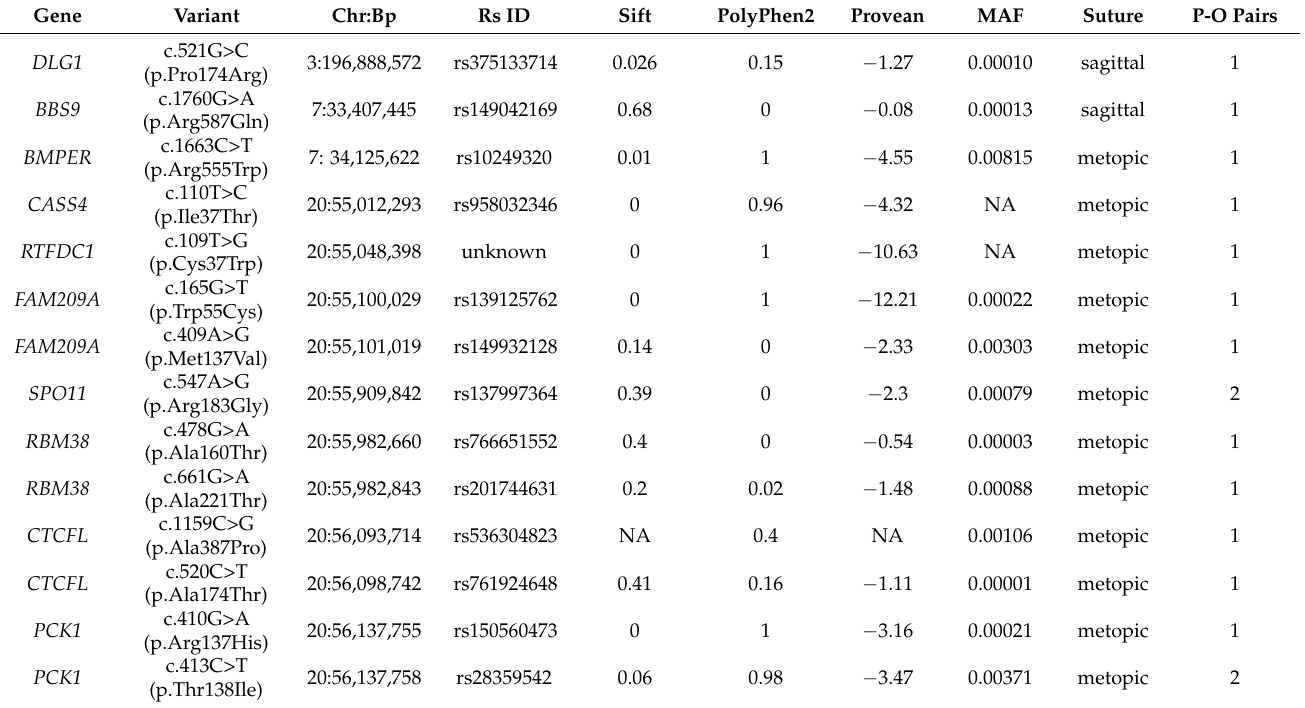
Table 1. Missense variants in 83 sNCS and 80 mNCS